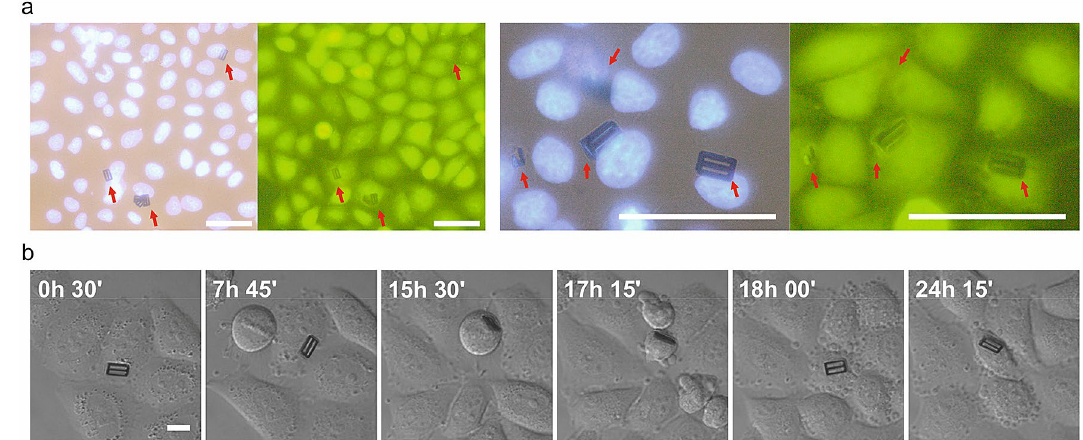
Figure 3. HeLa cells viability and tagging with Ni barcodes. ( a ) Images of two samples of fixed HeLa cells stained with DAPI (nuclei, blue) and the vital dye CellTracker (green fluorescence), with different magnification. Red arrows point the position of the Ni barcodes. Scale bars: 40 µm. ( b ) Images taken from a 24-h videomicroscopy showing a HeLa cell tagged with a Ni barcode inside (code number: 0000–0000 = 0). Cell before division (15 h 30 ′ ) and daughter cells (17 h 15 ′ ). Scale bar: 10